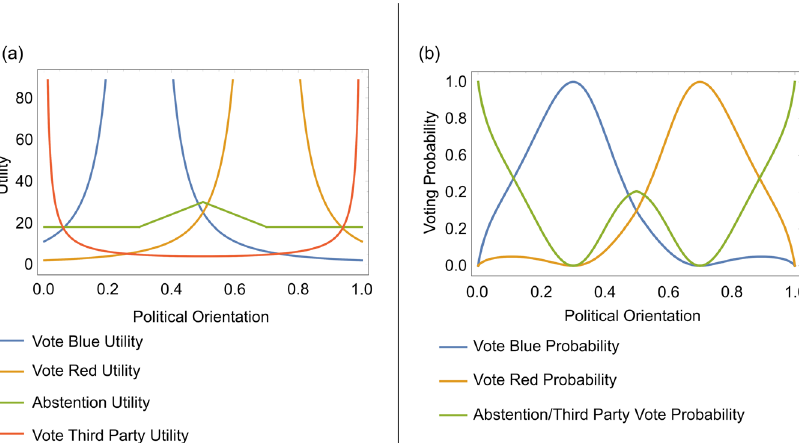
Fig. 2 Voter utility and voting behavior of individuals across the entire political spectrum with two fi xed political candidates. a shows the utility that a voter receives from different actions as a function of their position on the political spectrum, assuming candidate positions of 0.3 and 0.7 and a speci fi c set of model parameters ( P = 2, Q = 30, R = 1). b Maps these utilities into one of three behaviors: voting for the “ blue ” (left-leaning) candidate, the “ red ” (right-leaning) candidate, or voting for neither (staying home or selecting an ideologically motivated third-party candidate).